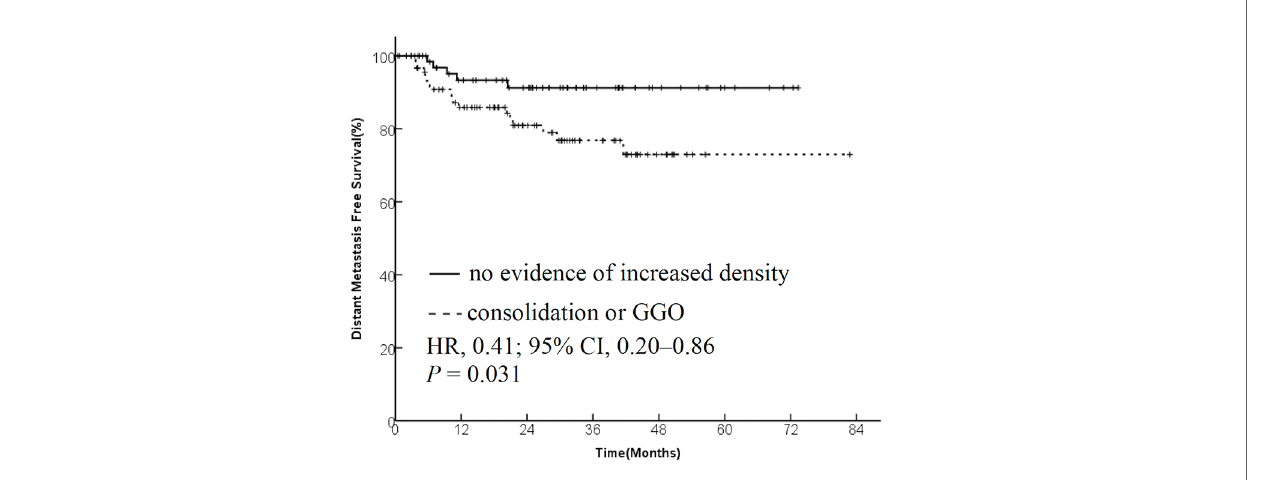
FIGURE 3 | Kaplan – Meier curves for distant metastasis – free survival.